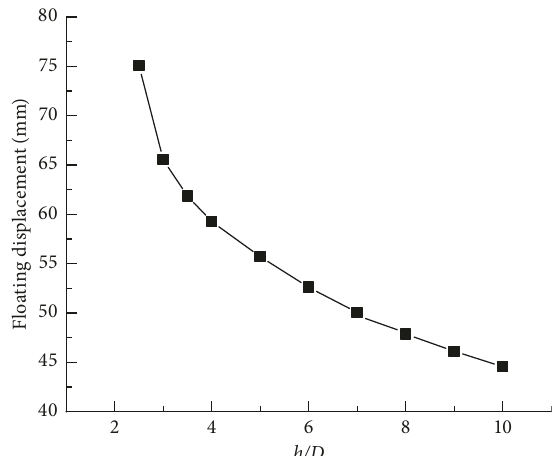
Figure 12: Variation of segment floating displacement.